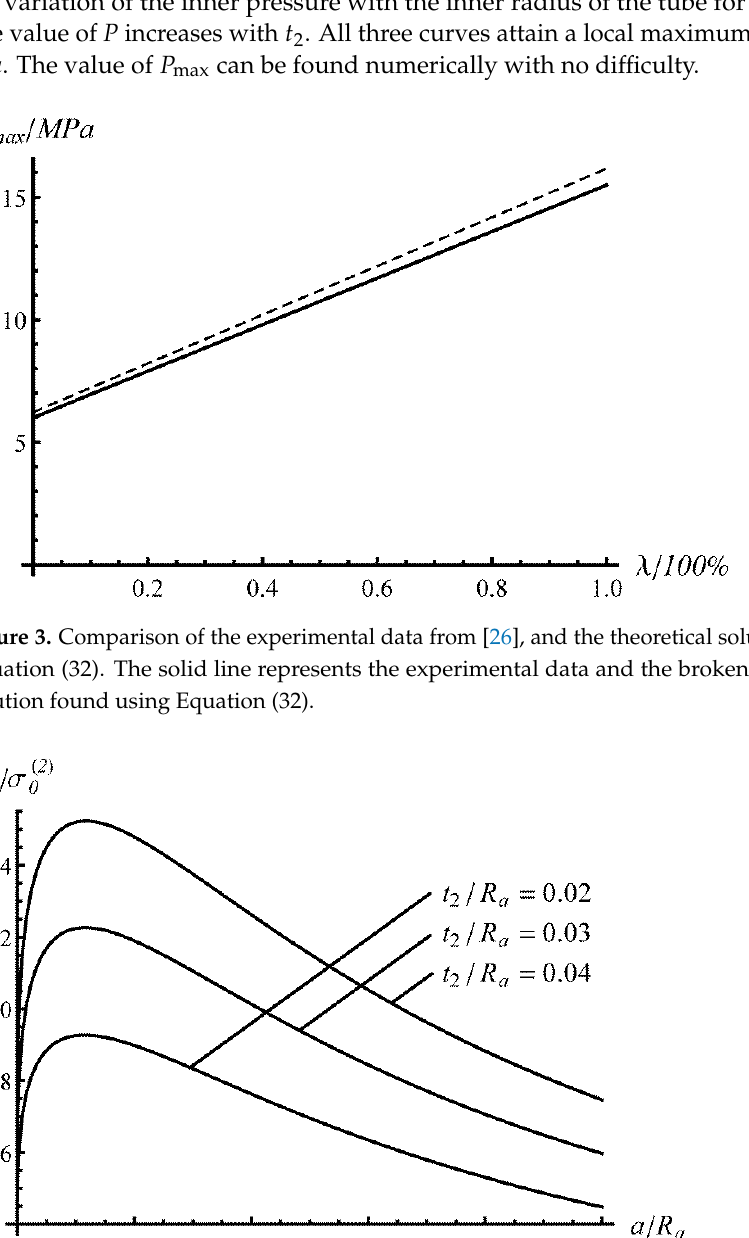
Figure 4. Dependence of the internal pressure on the inner radius for several initial thicknesses of the outer layer.